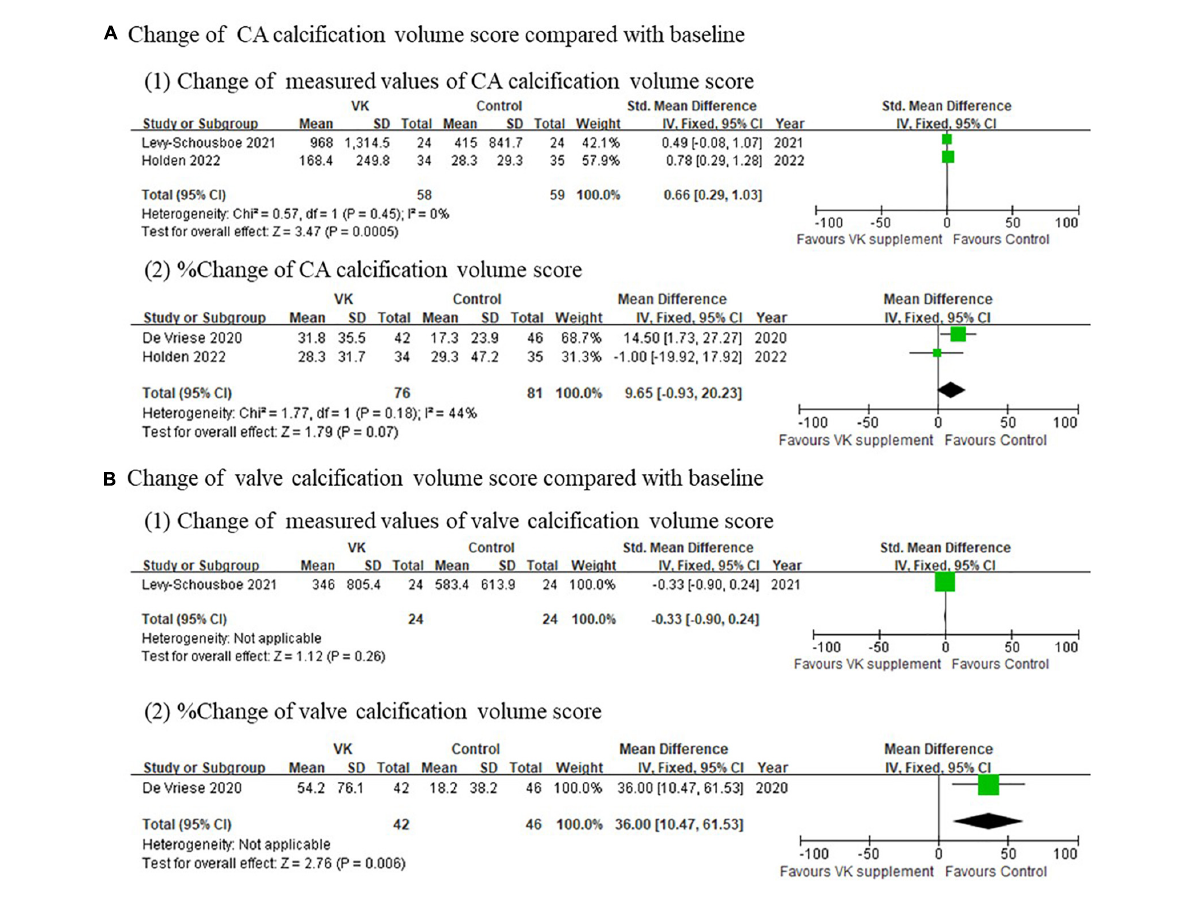
FIGURE4 Pooled changes of calcification volume score of coronary artery and valve after Vitamin K supplementation compared with baseline. (A) Change of calcification volume score of coronary arteries and (B) change of calcification volume score of valves after Vitamin K supplementation compared with baseline.